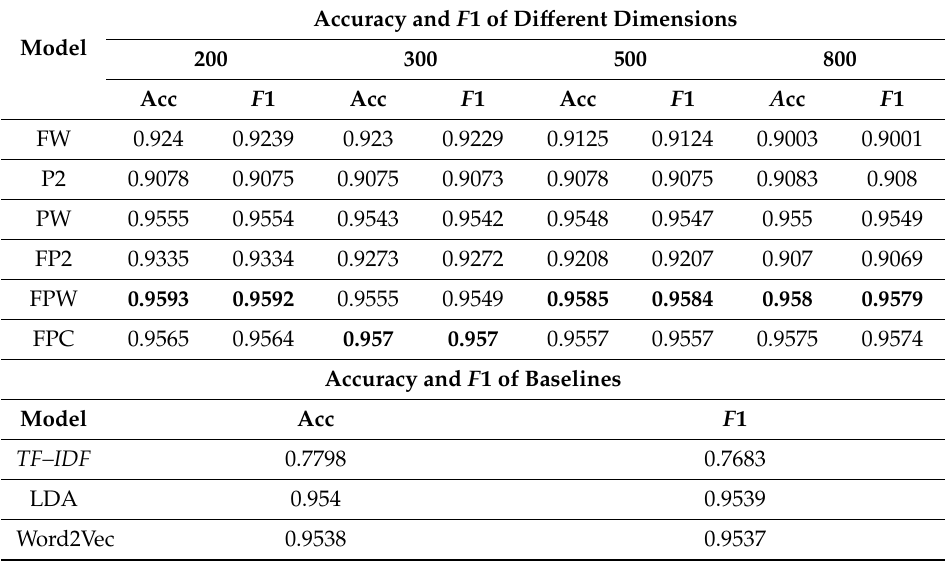
Table 1. Results of Amazon_6 in two classes for 4000 texts by k -nearest neighbor (KNN).